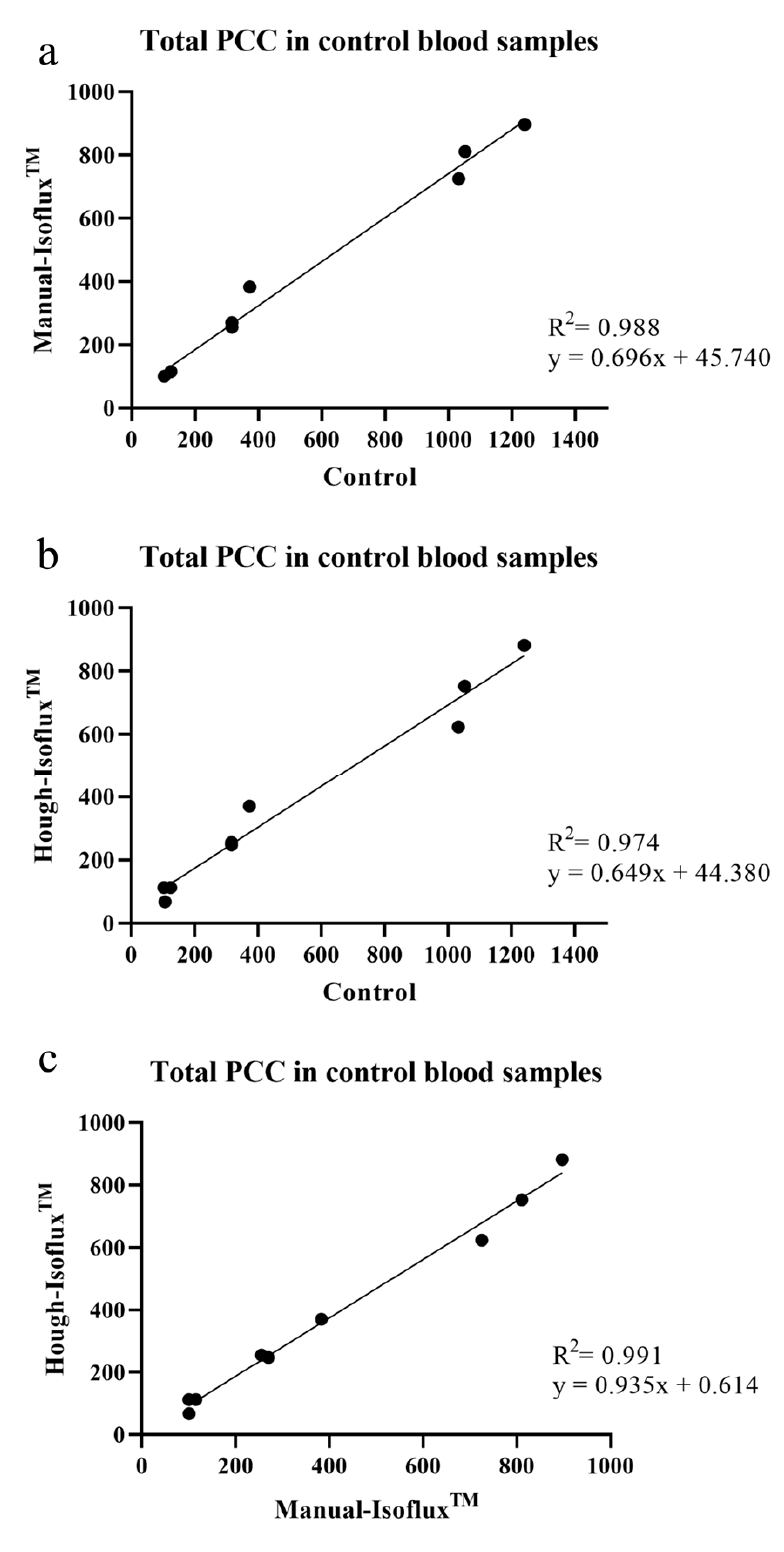
Figure 2. ( a ). Correlation of total PCCs in control blood samples between control and Manual- Isoflux TM System. ( b ). Total PCCs in control blood samples between control and Hough-Isoflux TM System. ( c ). Total PCCs in control blood samples between Manual-Isoflux TM System and Hough- Isoflux TM System.